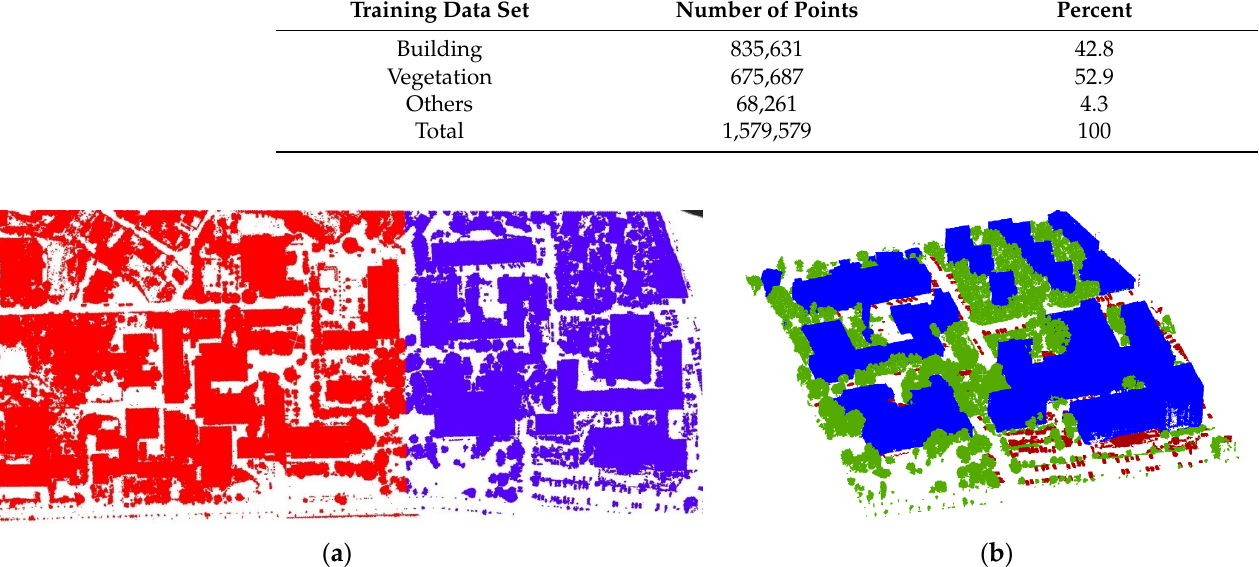
Figure 19. ( a ) The data set separated into training (~39%) (blue) and test (~61%) (red), ( b ) the training data set and its three classes (blue ‐ buildings, green ‐ vegetation, red ‐ others).